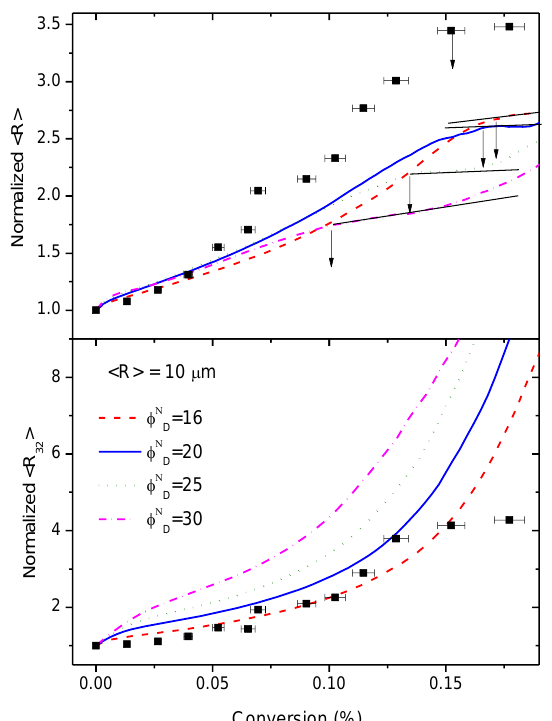
for several initial domain radii. tions